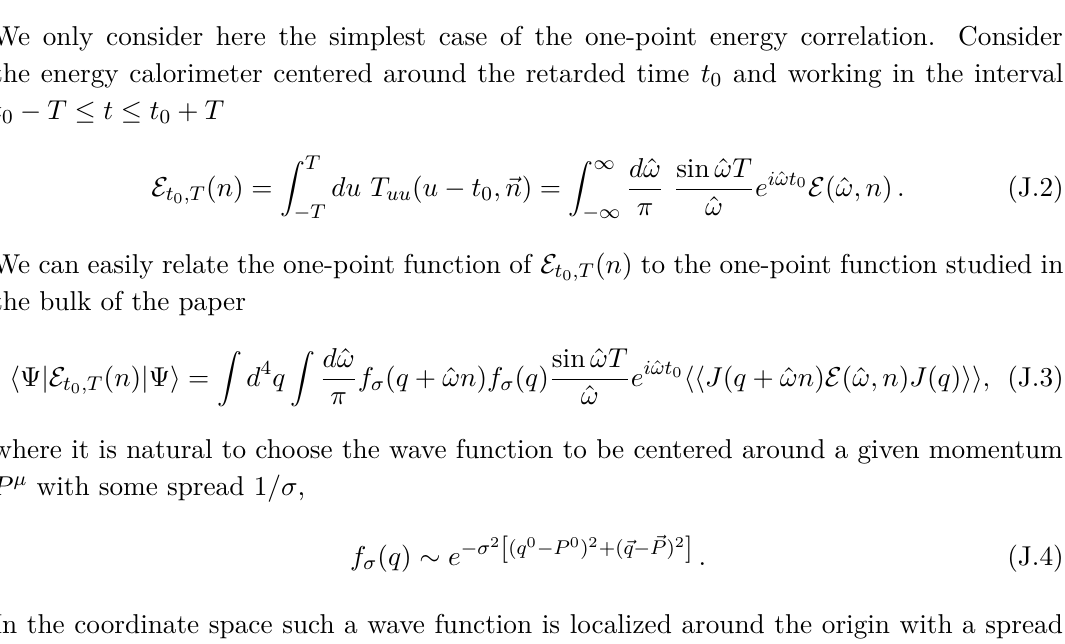
Figure 6 . Time dependence of the energy measurement for P µ = ( P 0 ,~ 0) with P 0 = 1 . We set σ = 10 (the left panel) and for σ = 1 (the right panel). In the latter case we observe small quantum oscillations around the asymptotic